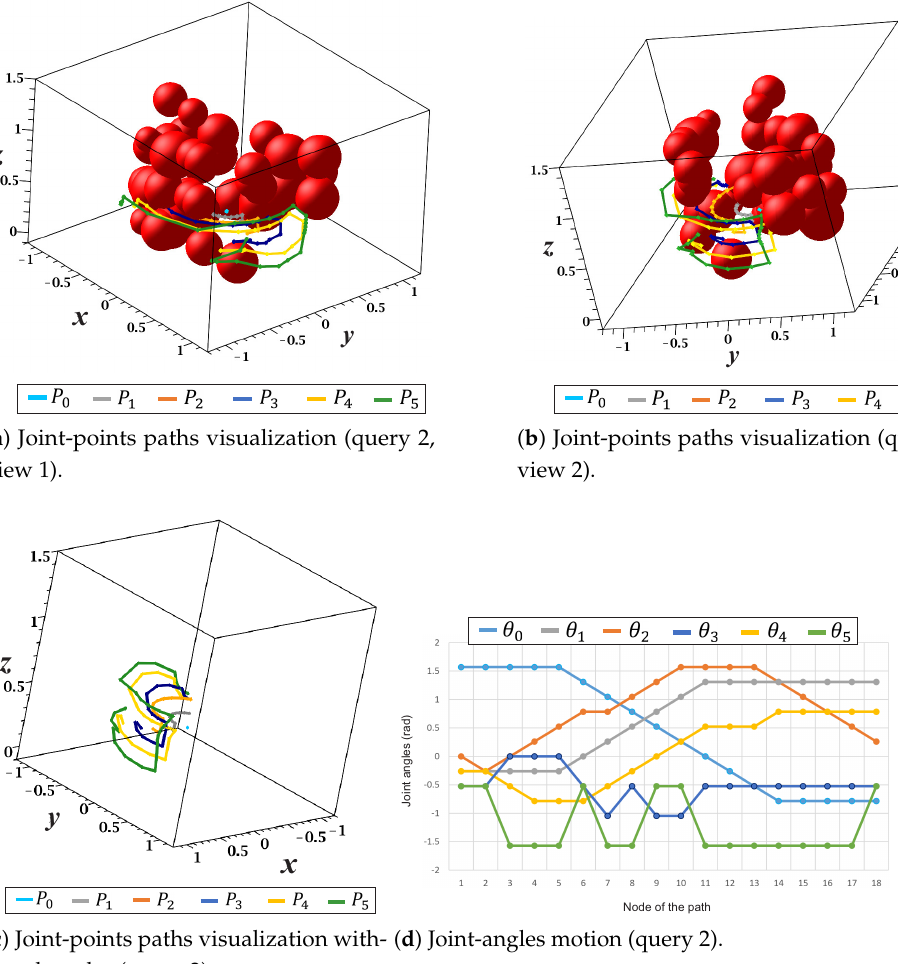
Figure 25. Joint-points paths and joint-angles motion (query